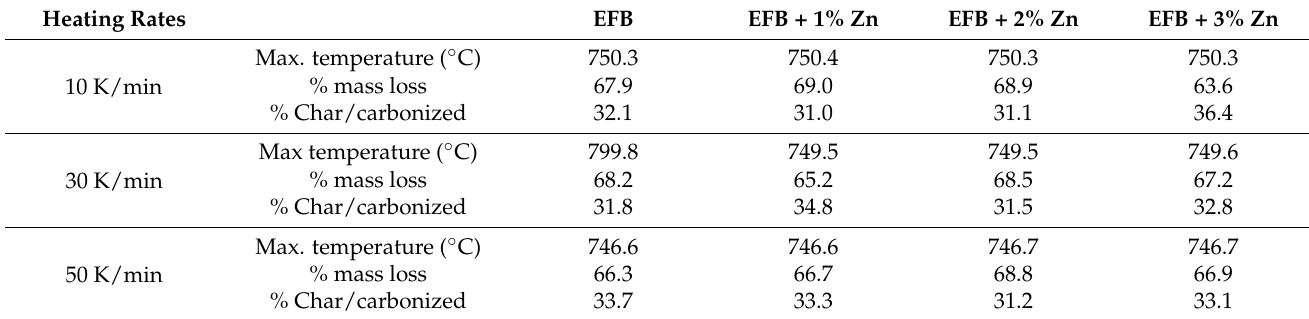
Table 2. Percentage of carbonization and mass loss for different heating rates.